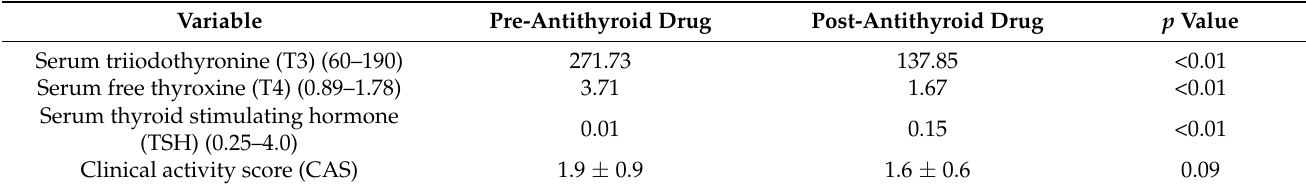
Table 2. Thyroid function test and clinical activity score between pre- and post-antithyroid drug treatment of the subjects.